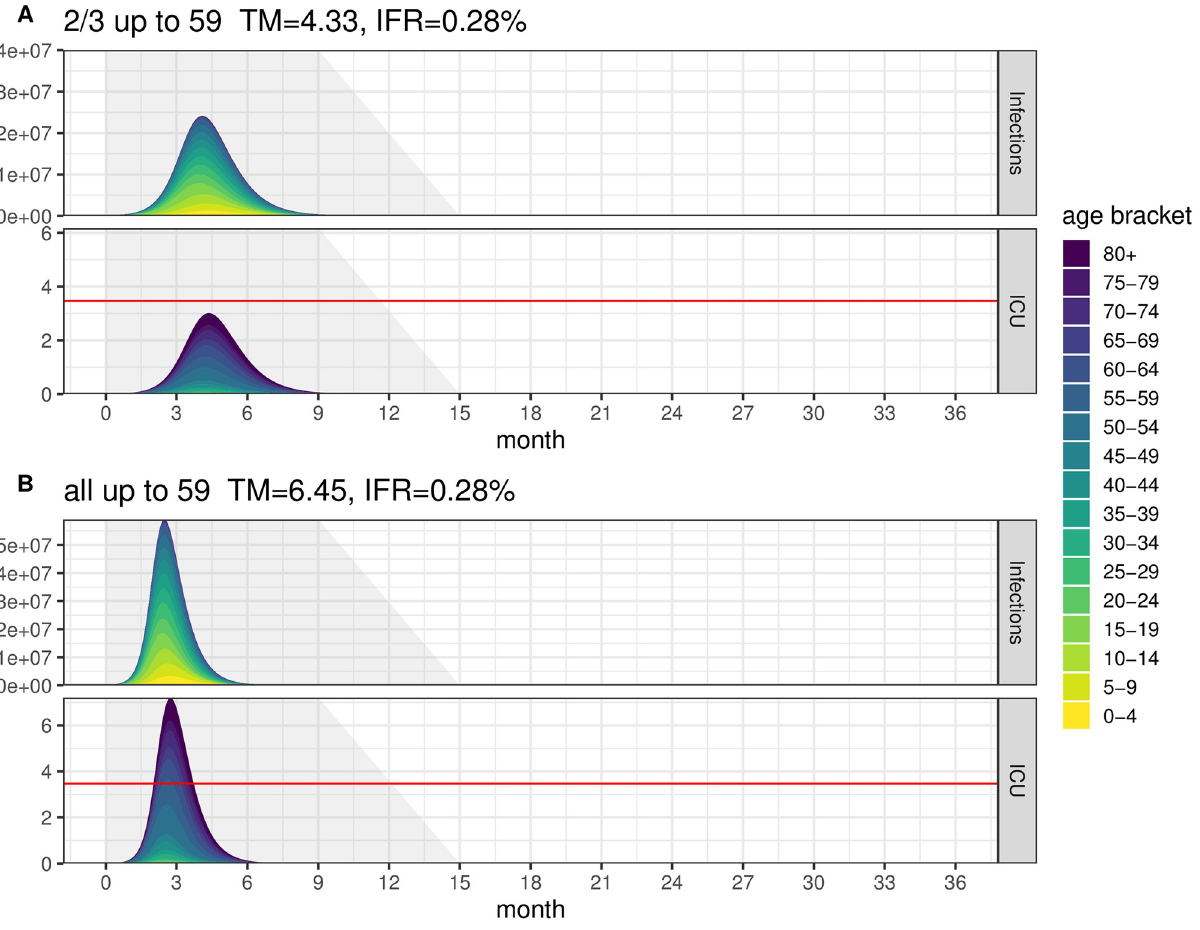
Fig 6. A : 2/3 under 59 released at normal levels. B : All under 59 released at normal levels.